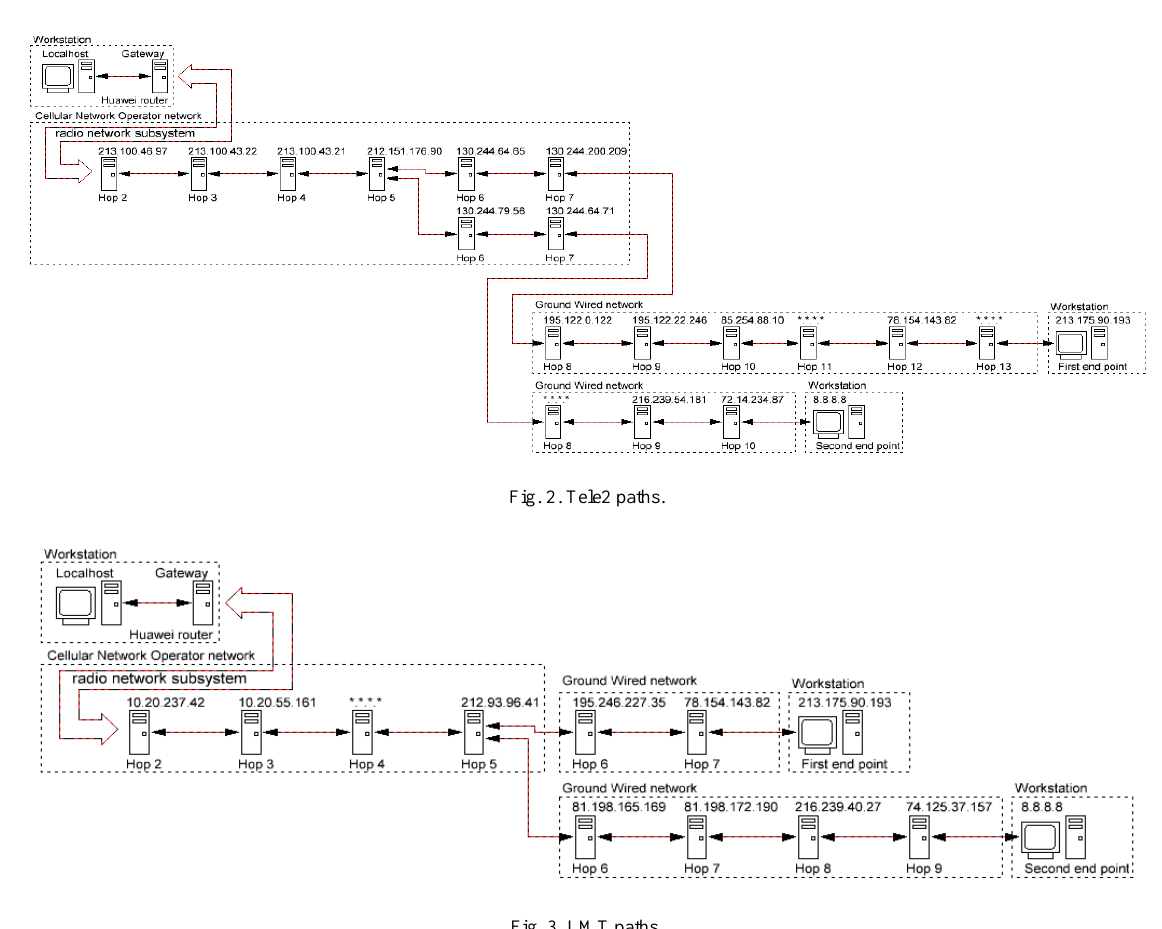
Fig. 3. LMT paths.